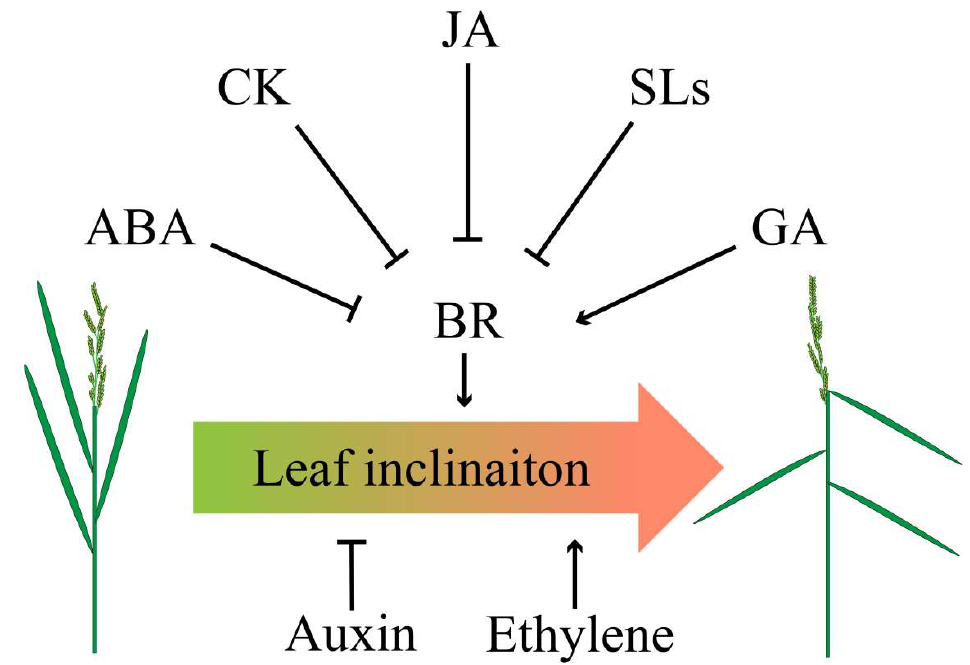
Figure 3. Crosstalk of phytohormones in determining leaf angle. Abscisic acid (ABA), CK, jasmonic acid (JA), and strigolactones (SLs) negatively regulate BR, thereby inhibiting leaf angle, whereas gibberellins (GA) positively coordinates BR to increase leaf angle. Application of auxin results in erect leaf while ethylene leads to flat leaf.